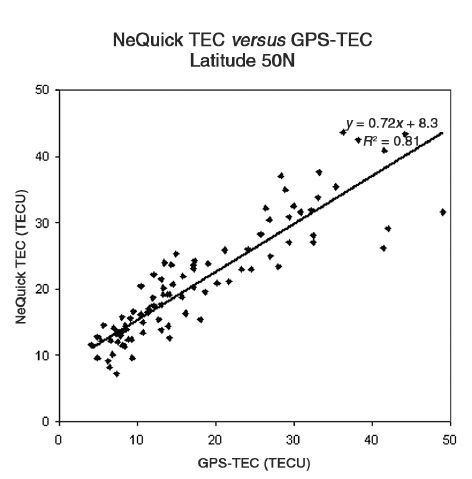
Fig. 8.11. Comparison of TEC up to 20000 km estimated by the NeQuick model with experimental measure- ments obtained from GPS observations at Hailsham in